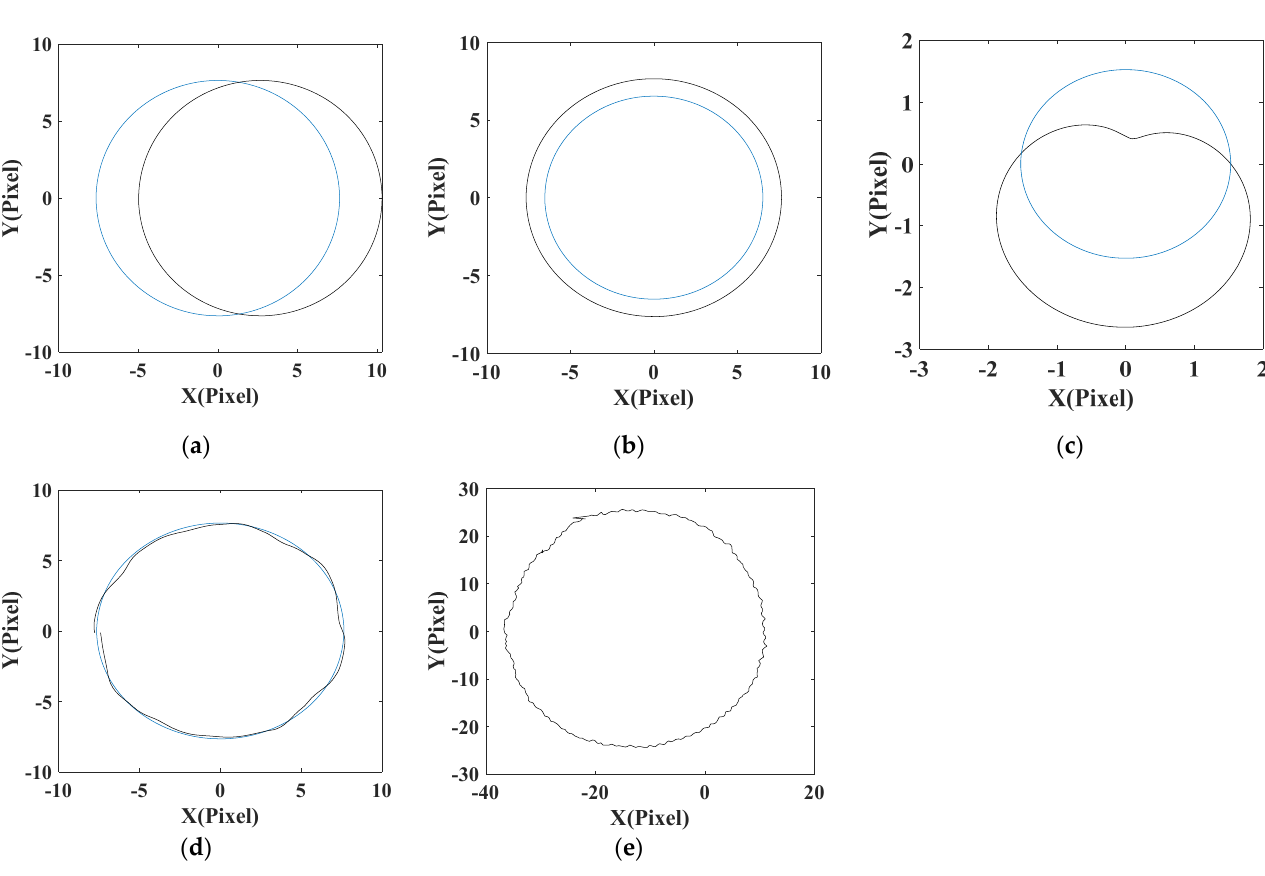
Table 1. System parameters used in simulation.